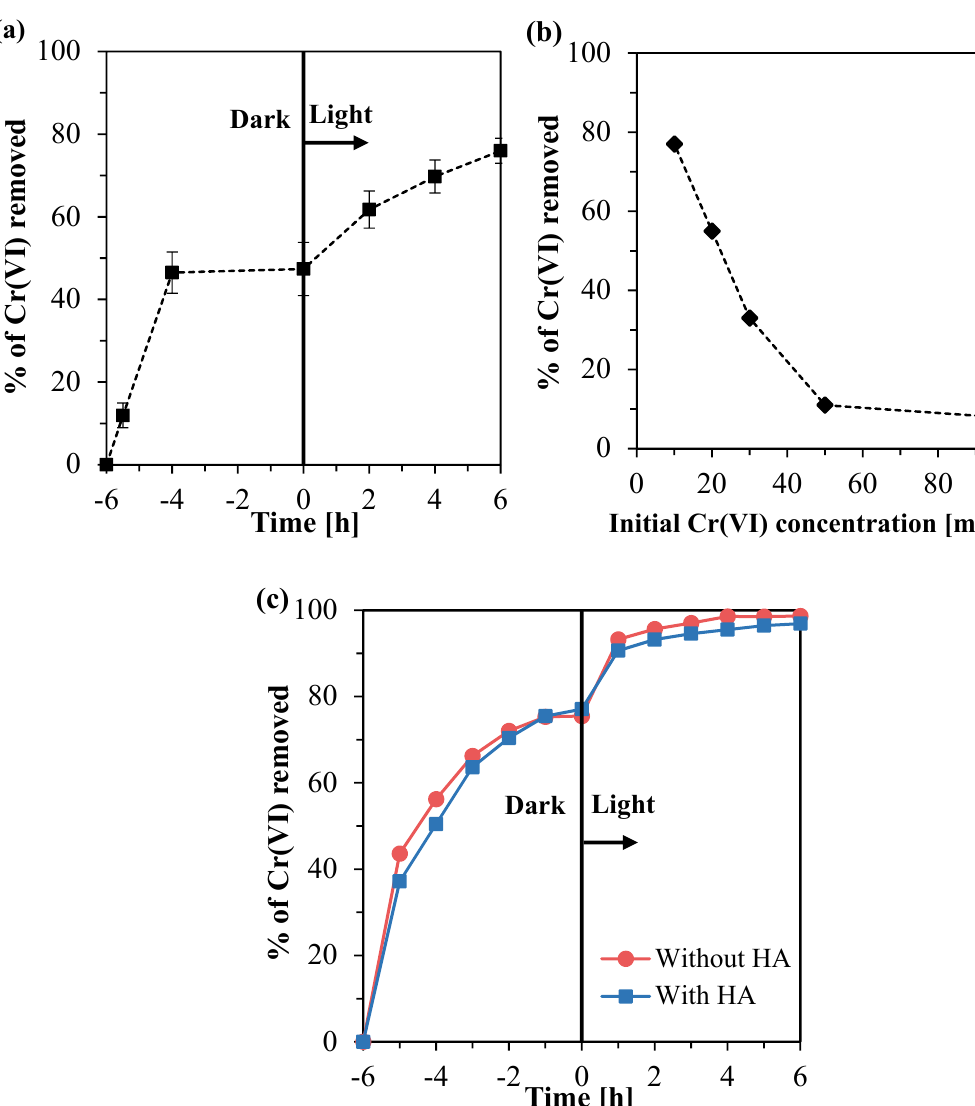
Figure 9. Percentages of Cr(VI) removed using immobilized Ce–ZrO 2 in the tests with: ( a ) model solution containing 10 mg L − 1 of Cr(VI); ( b ) model solutions containing different initial Cr(VI) concentrations; ( c ) diluted galvanizing industry effluent.